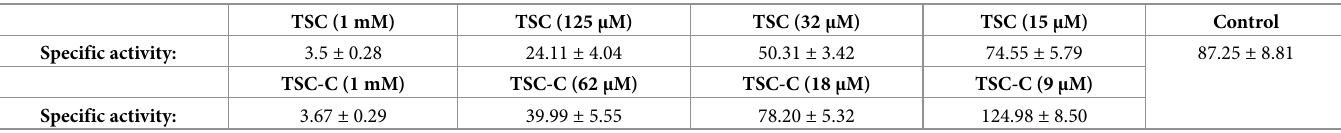
Table 3. Inhibitory effect of TSC and TSC-C in the activities of